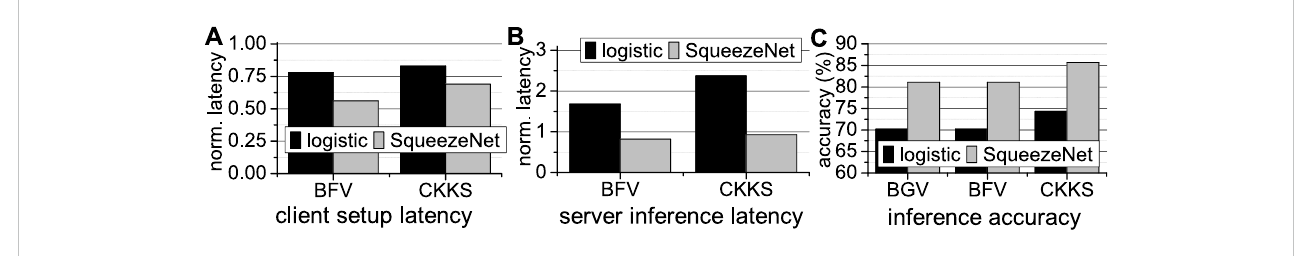
FIGURE 4 ThelatencyandaccuracycomparisonQ14ofvariousFHE-basednetworks (A) :clientsetuplatency; (B) :serverinferencelatency; (C) :inferenceaccuracy; all latency results are normalized to BGV.